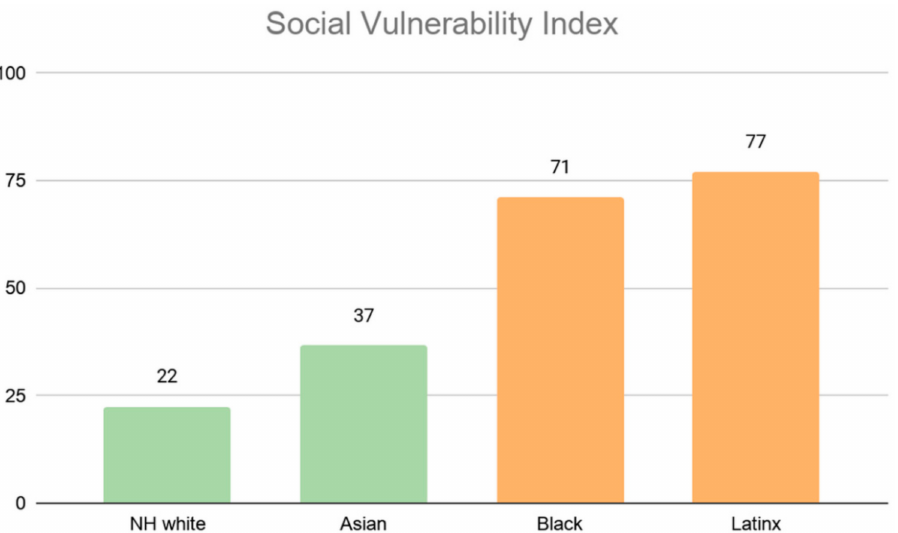
Figure 14. Average social vulnerability index by Los Angeles County neighborhood’s racial